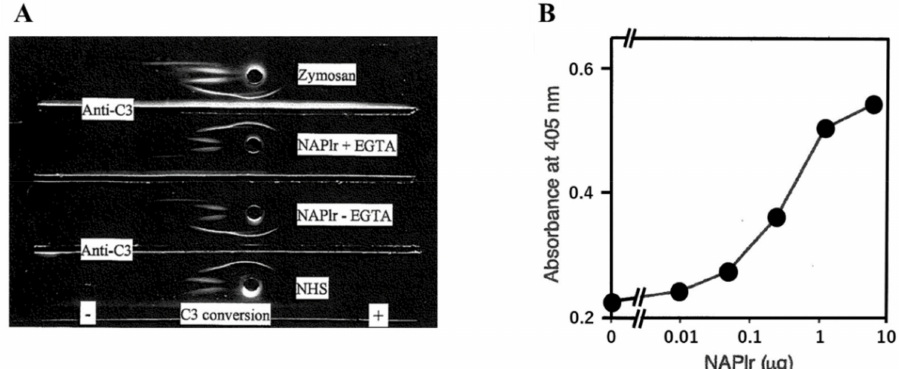
Figure 13. Complement activation by NAPlr. ( A ) Immunoelectrophoresis showing conversion of C3 after incubation of NHS with NAPlr with or without Mg 2+ and EGTA (middle). As a possible control, zymosan was added to NHS and indicates activated C3 (top). NHS not incubated with NAPlr shows a single arc of C3 (bottom). ( B ) Formation of iC3b from C3 in NHS incubated with various amounts of NAPlr. The plots use average values from triplicate assays. NAPlr: nephritis-associated plasmin receptor, EGTA: ethylene glycol tetraacetic acid, NHS: normal human serum.